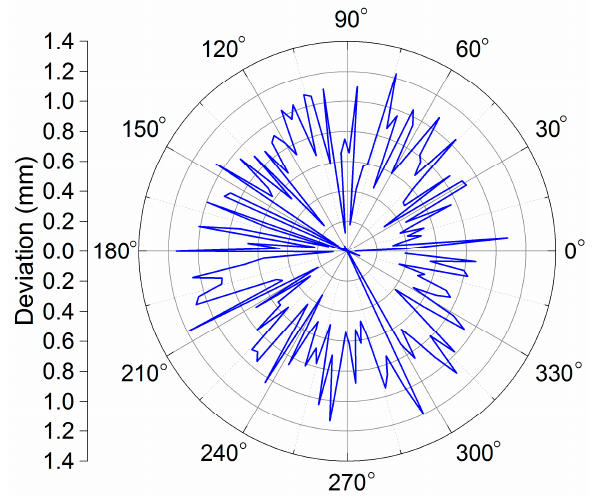
for disc of hub. disc of hub. Appl. Sci. 2019 , 9 , x FOR PEER REVIEW